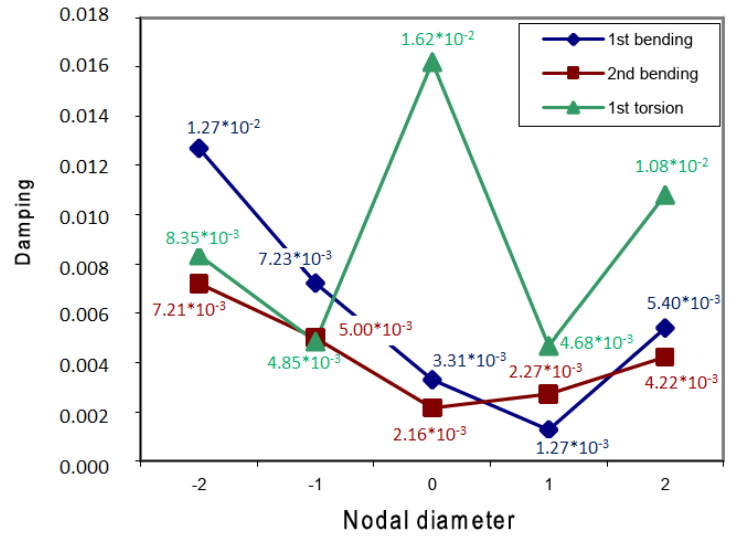
Figure 4. Aerodynamic damping over IBPAs for different modes.